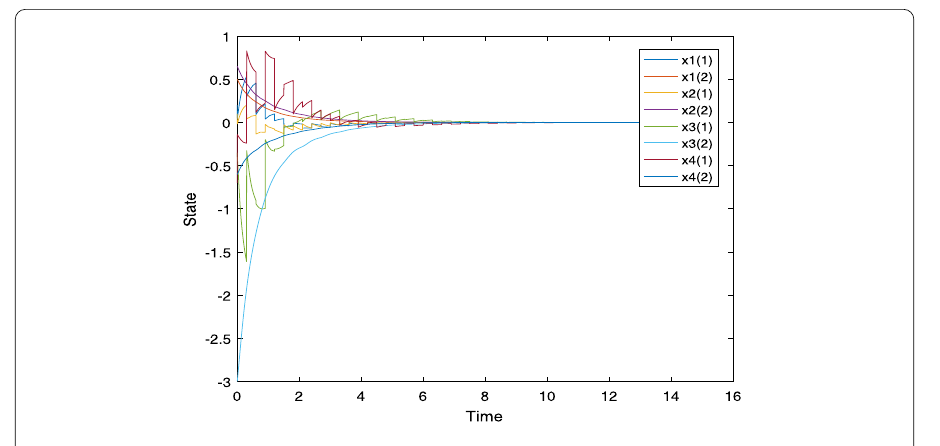
Figure 7 State trajectory of (4.1) with control